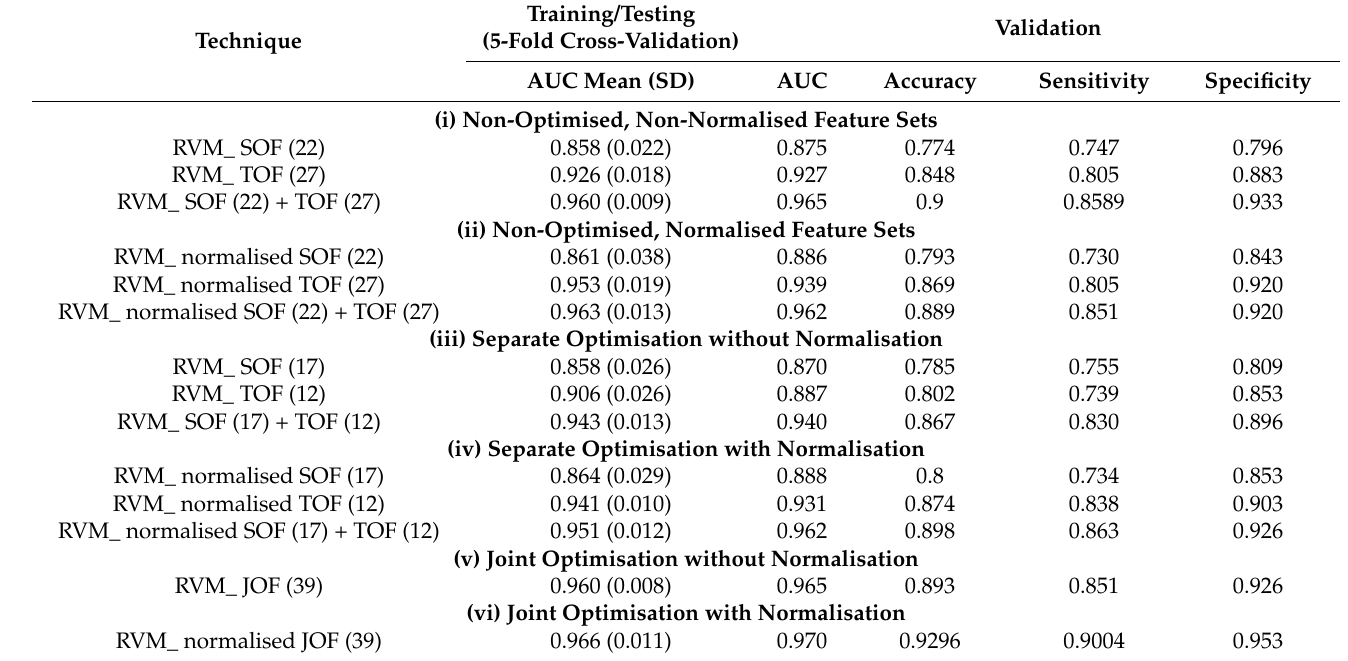
Table 1. Performance of RVM with different feature sets on training/testing and validation data.